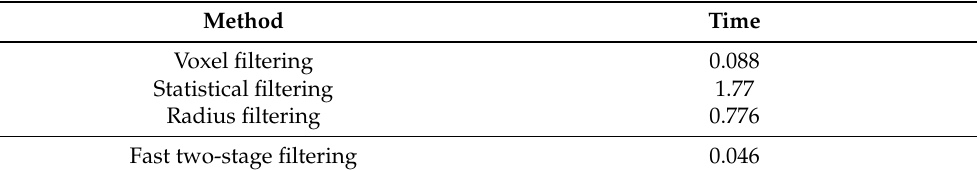
Table 2. Comparison of the speed of different filter methods. Speed is measured in seconds-per-frame (point cloud).